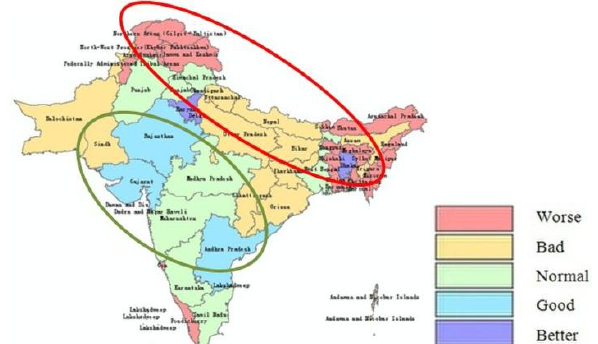
Figure 2. The political and military unit division of South Asia